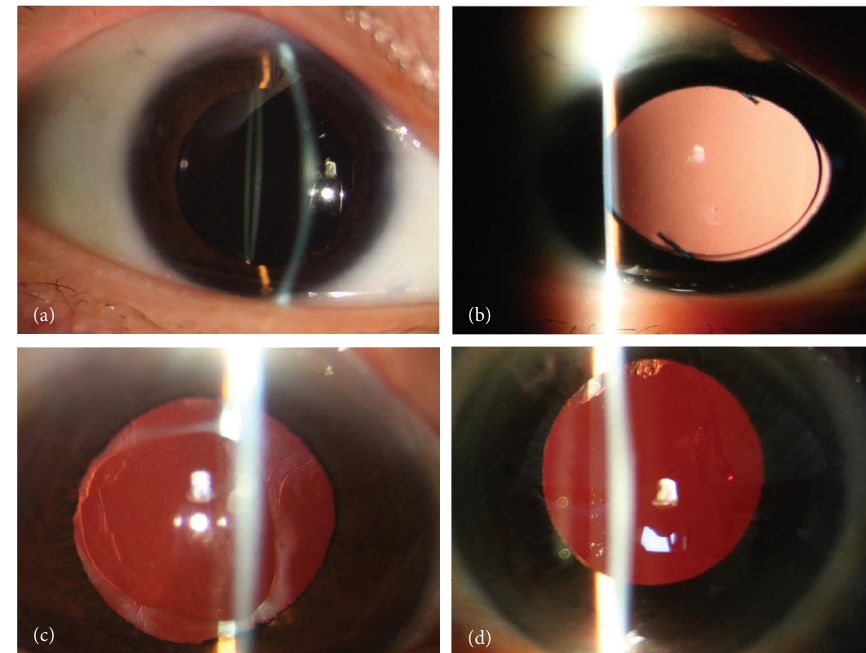
Figure 4: Postoperative pictures of cases receiving the present transscleral fxation: (a, b) twenty-two-month postoperative overview of a case with dislocated IOL. Suture erosion or scleral atrophy was not observed. (c, d) Te IOLs were well centered for one case after a three- month follow-up (c) and the other after an eleven-month follow-up (d).